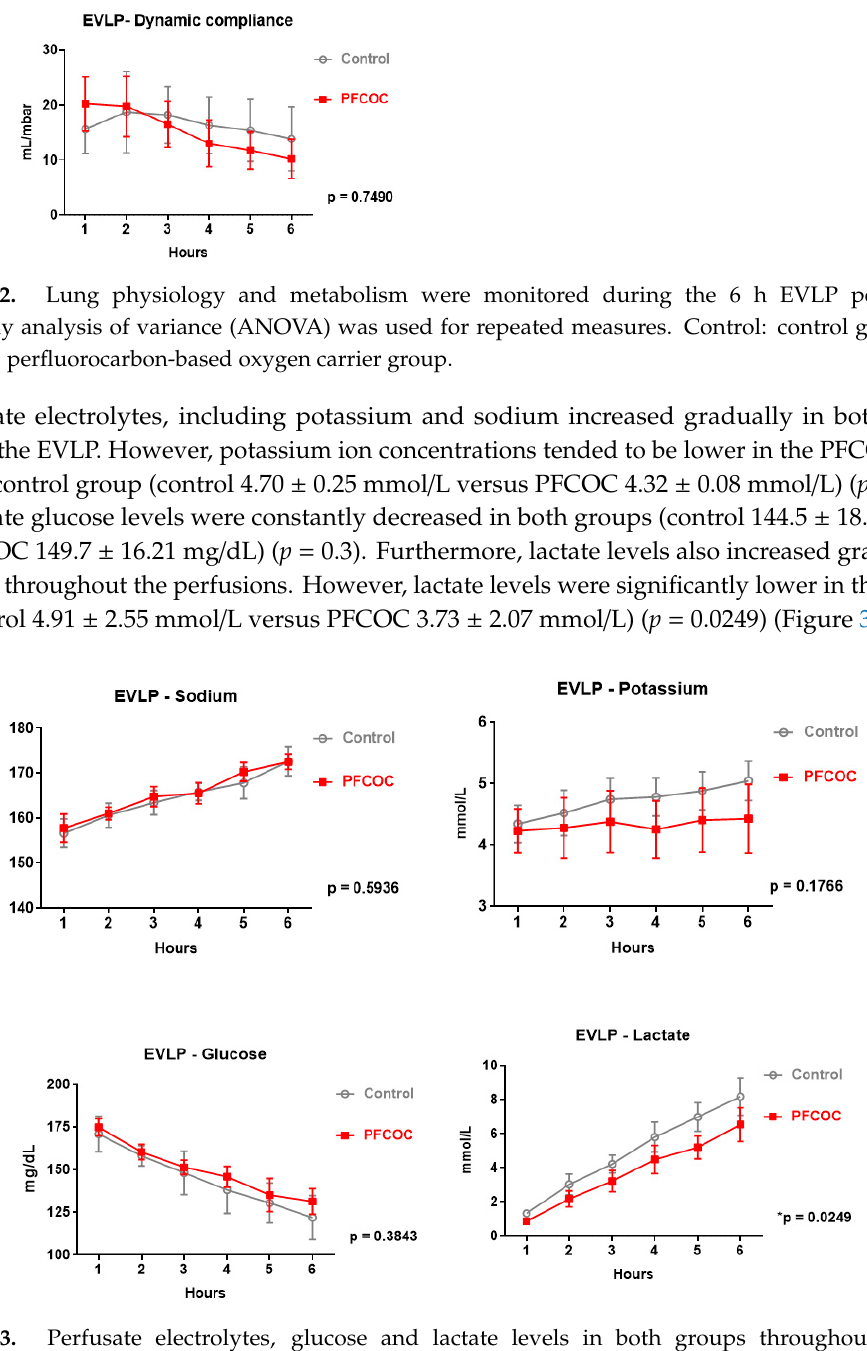
lymphocytes (control 9.4 ± 7.98% versus PFCOC 18.13 ± 6.68%, p = 0.16) in the PFCOC group. Perfusate cytokine levels are shown in Table 1. Table 1. Perfusate cytokine levels at the end of 6 h EVLP. Cytokine 0.7302 Values are given as mean ± standard deviation. Hemodynamic and physiologic parameters during the 4 h of reperfusion are shown in Figure 4. The control group had worse mean arterial pressure during the reperfusion period compared to the treated group (control 52.83 ± 7.68 mmHg versus PFCOC 61.54 ± 11.88 mmHg) ( p = 0.035). The